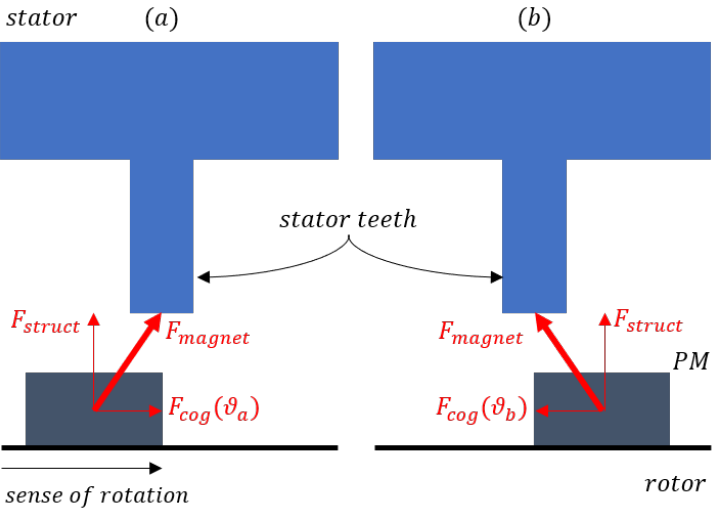
Figure 4. Schematizing of the concept of alternating between “attractive” ( a ) and “repulsive” ( b )